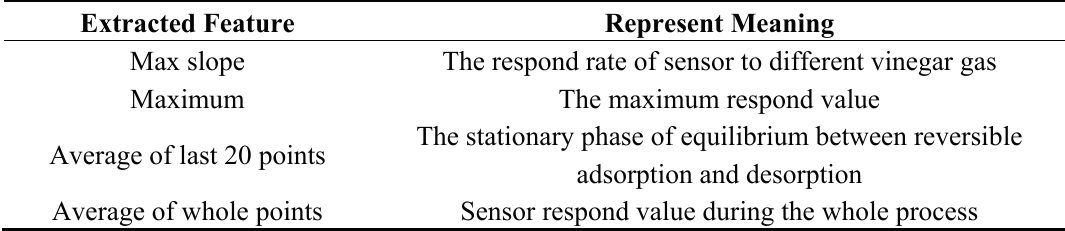
Table 4. Description of features extracted from original response curves in